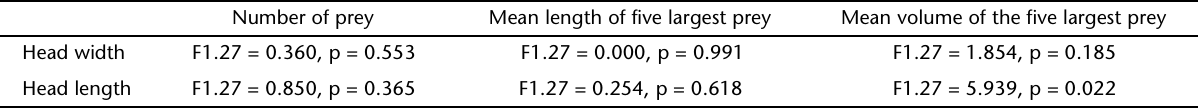
Table II. Regression statistics relating lizard morphology (log-transformed) to number, mean length (mm) and mean volume of the five largest prey items of C. ocellifer at the Morro do Chapéu.